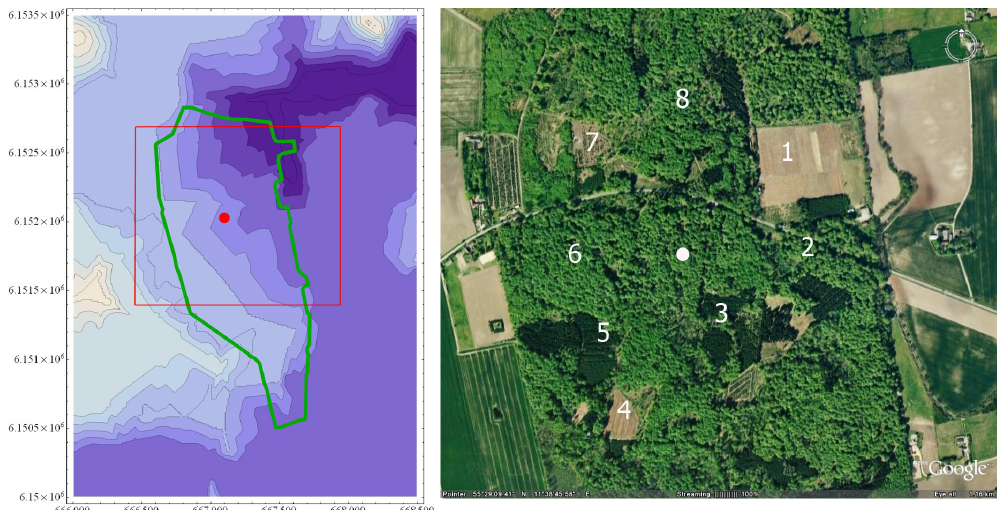
Fig. 2. Map and aerial photography of the Sorø site. The height contours (left pane) signify 2m height differences and the red box outlines the area in the photograph. The numbers in the right pane refer to the following features: (1) 8 h C to a large clearing in the direction of ≈ 60 ◦ from the mast, (2) Narrow strip of 17 h C homogeneous beech forest to forest edge in ≈ 90 ◦ , (3) 4 h C to a 15m tall plantation of Norway Spruce in 155 ◦ , (4) 13 h C to a clearing in 200 ◦ , (5) 10 h C to another 15m tall plantation of Norway spruce in 225 ◦ , (6) 17 h C to the forest edge in 260 ◦ , (7) 9 h C to a clearing with younger beech of 5–6m height in 315 ◦ and finally (8) 26 h C to the forest edge in 360 ◦ . The white dot corresponds to the location of the